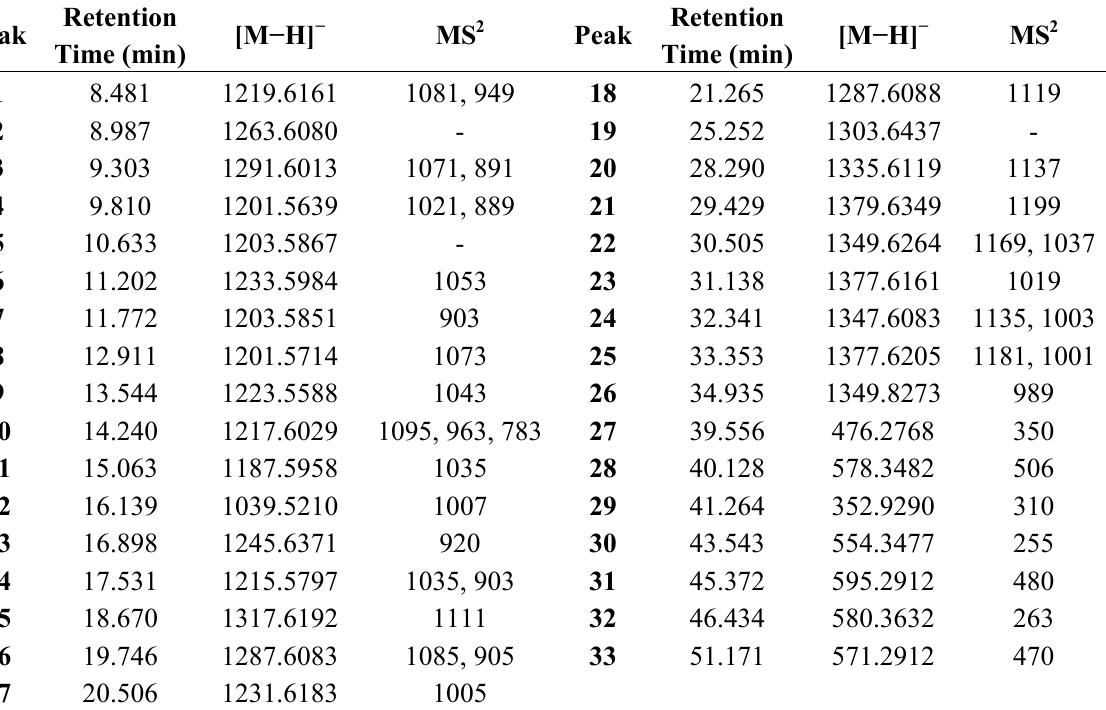
Table 1. Estimated molecular weights for saponins in tea seed